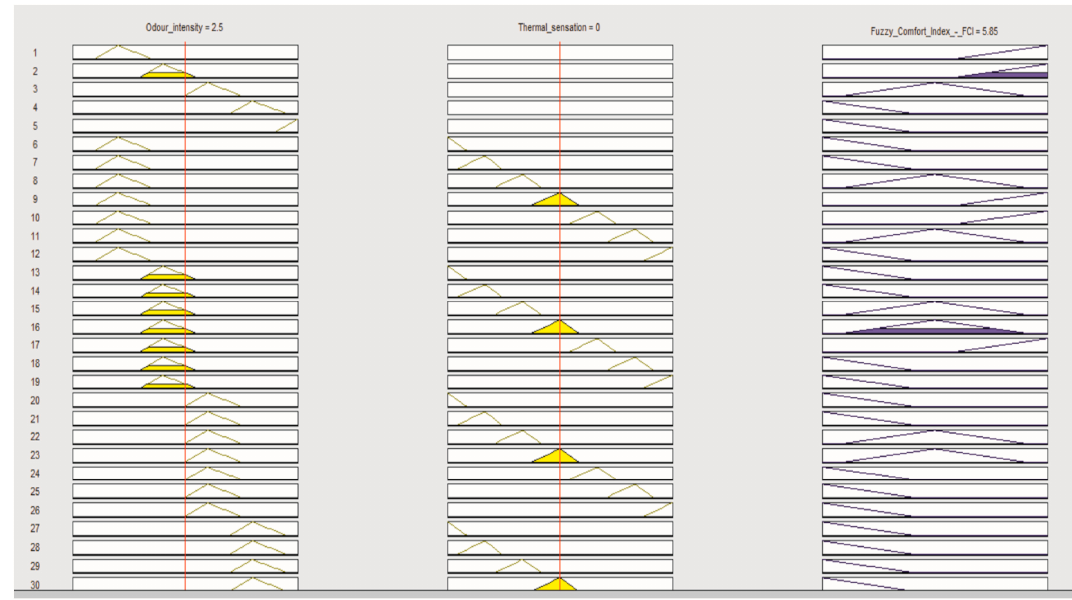
Figure 6. Fuzzy rules.